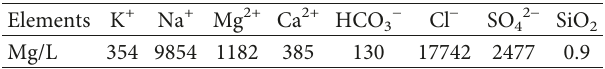
Table 3: Major chemical components of seawater from the East China Sea.